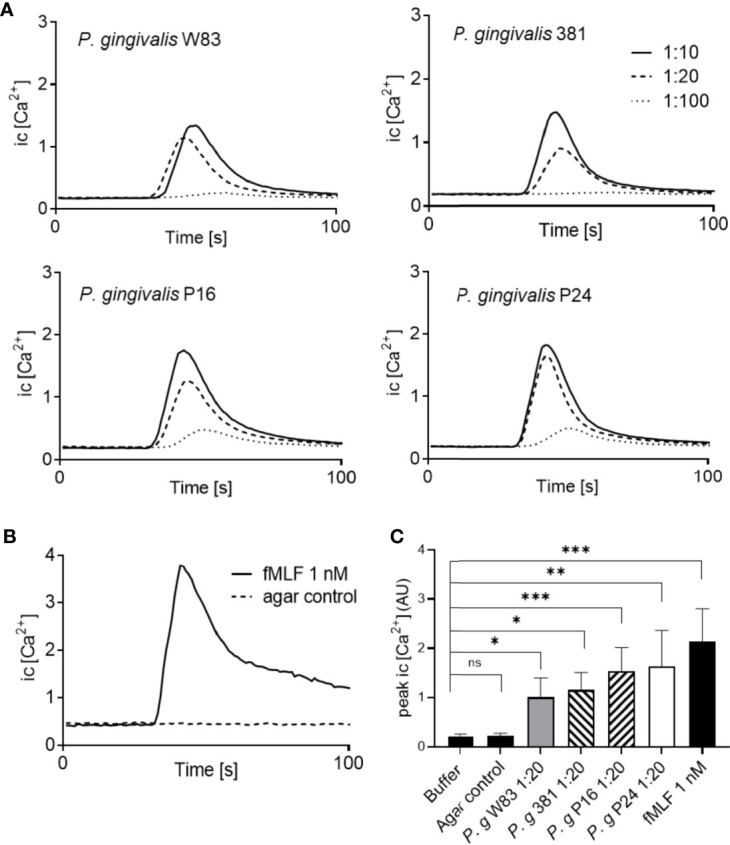
P. gingivalis supernatants trigger transient Ca2+ signals in neutrophils. Neutrophils isolated from buffy-coats from healthy blood donors were co-stained with Ca2+ dyes Fura-Red and Fluo-3. The fluorescence emission, after stimulation, was analyzed simultaneously in FL-1 and FL-3 and the curves represent a ratio between Fluo-3 and Fura-Red fluorescence. (A) Neutrophil stimulation with P. gingivalis supernatants induced transient rises in intracellular Ca2+ concentration in a dose-dependent manner. (B) A rise in intracellular Ca2+ concentration was also induced by fMLF (1 nM), while no changes in intracellular Ca2+ concentration were seen after stimulation with agar control supernatants (without bacteria). (C) Peak values of neutrophil intracellular Ca2+ signals after stimulation with the four P. gingivalis culture supernatants (1:20) (mean + SD, n = 5–13). Kruskal-Wallis test followed by Dunn´s multiple comparison test was used for statistical analysis. ns >0.05, *<0.05, **< 0.01, ***< 0.001.